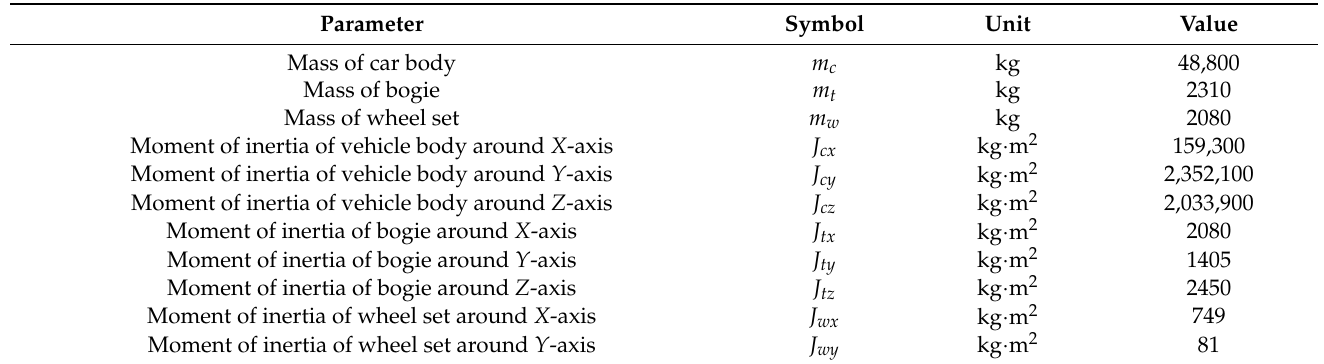
Figure 2. Vehicle model: ( a ) side view; ( b ) front view; and ( c ) vertical view. Table 1. Vehicle